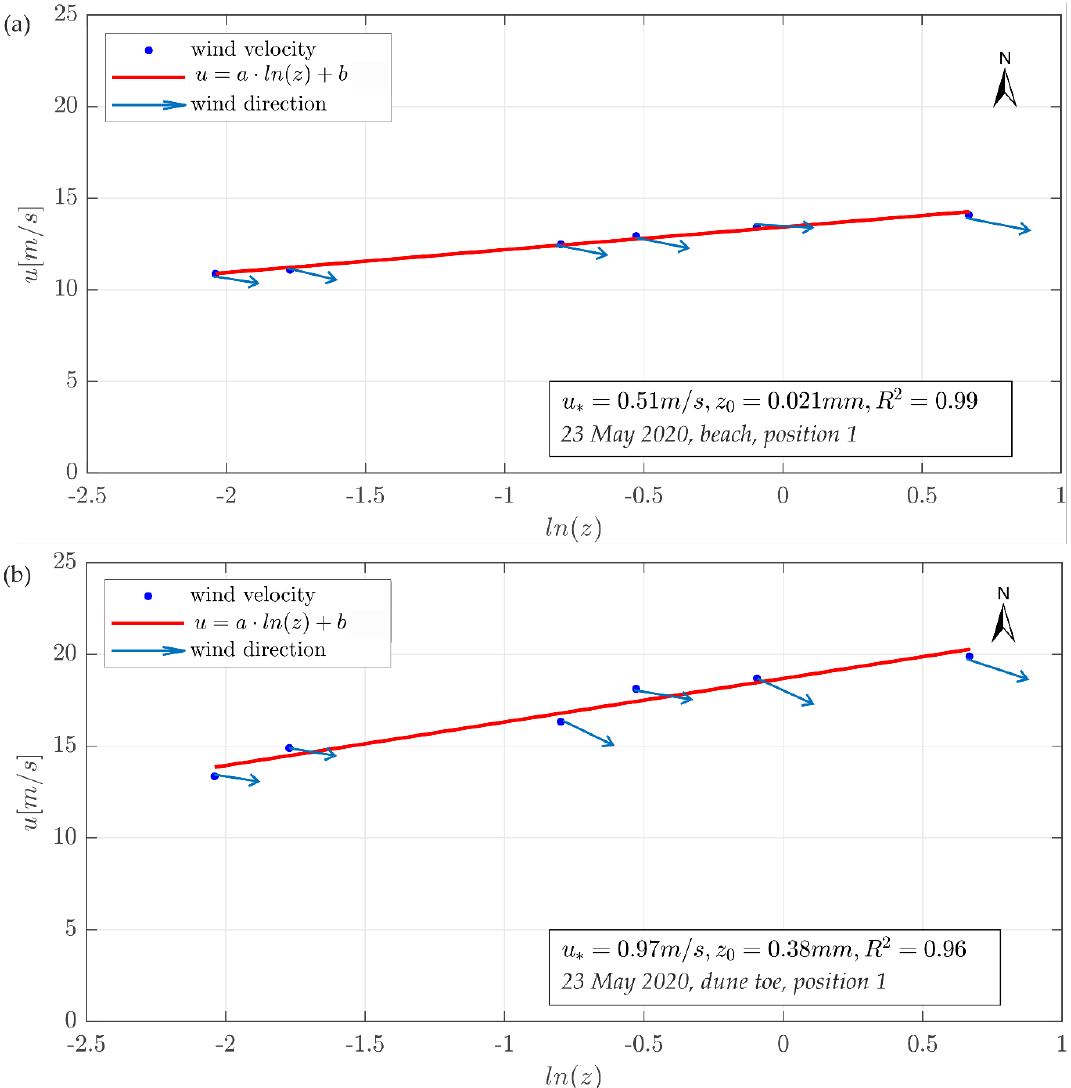
Figure 7. Representative example of a velocity profile for the locations ( a ) beach and ( b ) dune toe on the study site of Langeoog. The blue dots show the measured wind velocity, the blue vectors show the wind direction, and the red line indicates the regression line, see Equation (1).